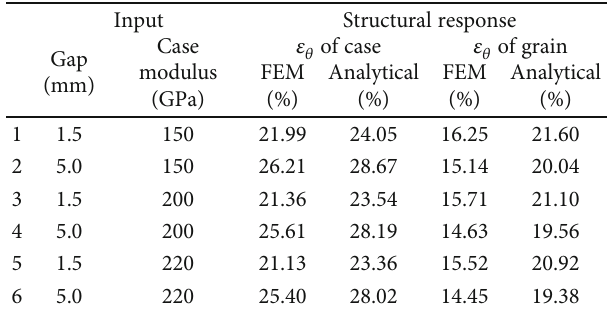
Figure 11: Circumferential strain versus time curve of point A, the propellant grain inner surface, and the case. Table 2: Calculation results of circumferential strain. Table 3: Calculation results of circumferential strain of another example (a double-pulse SRM with twice the diameter; R / h stays the